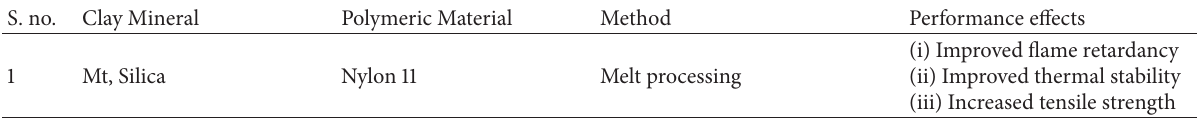
Figure 4: Two types of important nylon structures, nylon 6 and nylon 66 [22]. Table 3: Possible effects of clay mineral on the performance of polymeric